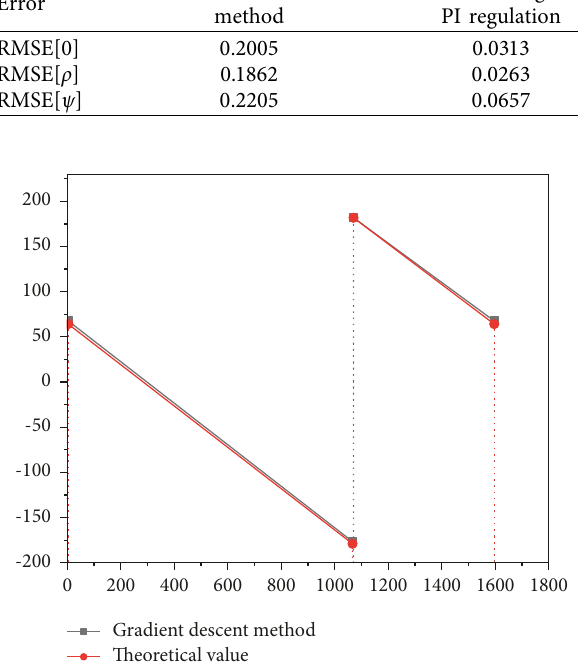
Figure 3: Comparison between calculation results and theoretical values of heading angle based on gradient descent under low